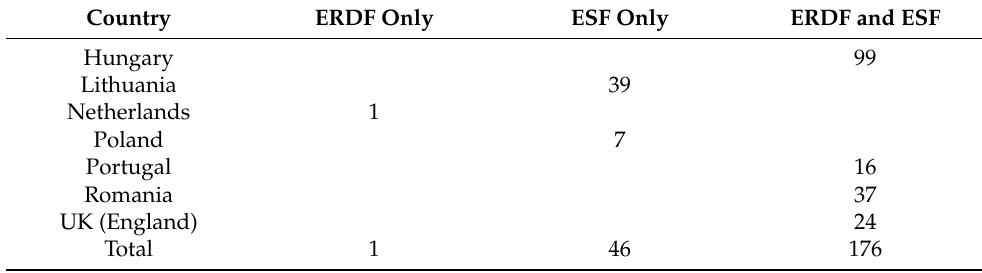
Table 3. Urban CLLD LAGs in